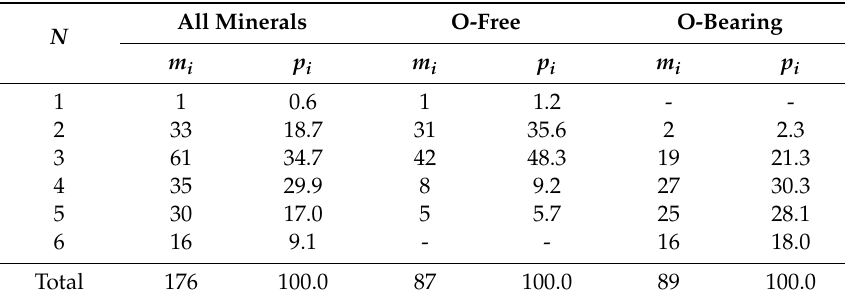
Table 1. The mineral systems ( N ) of Te minerals.